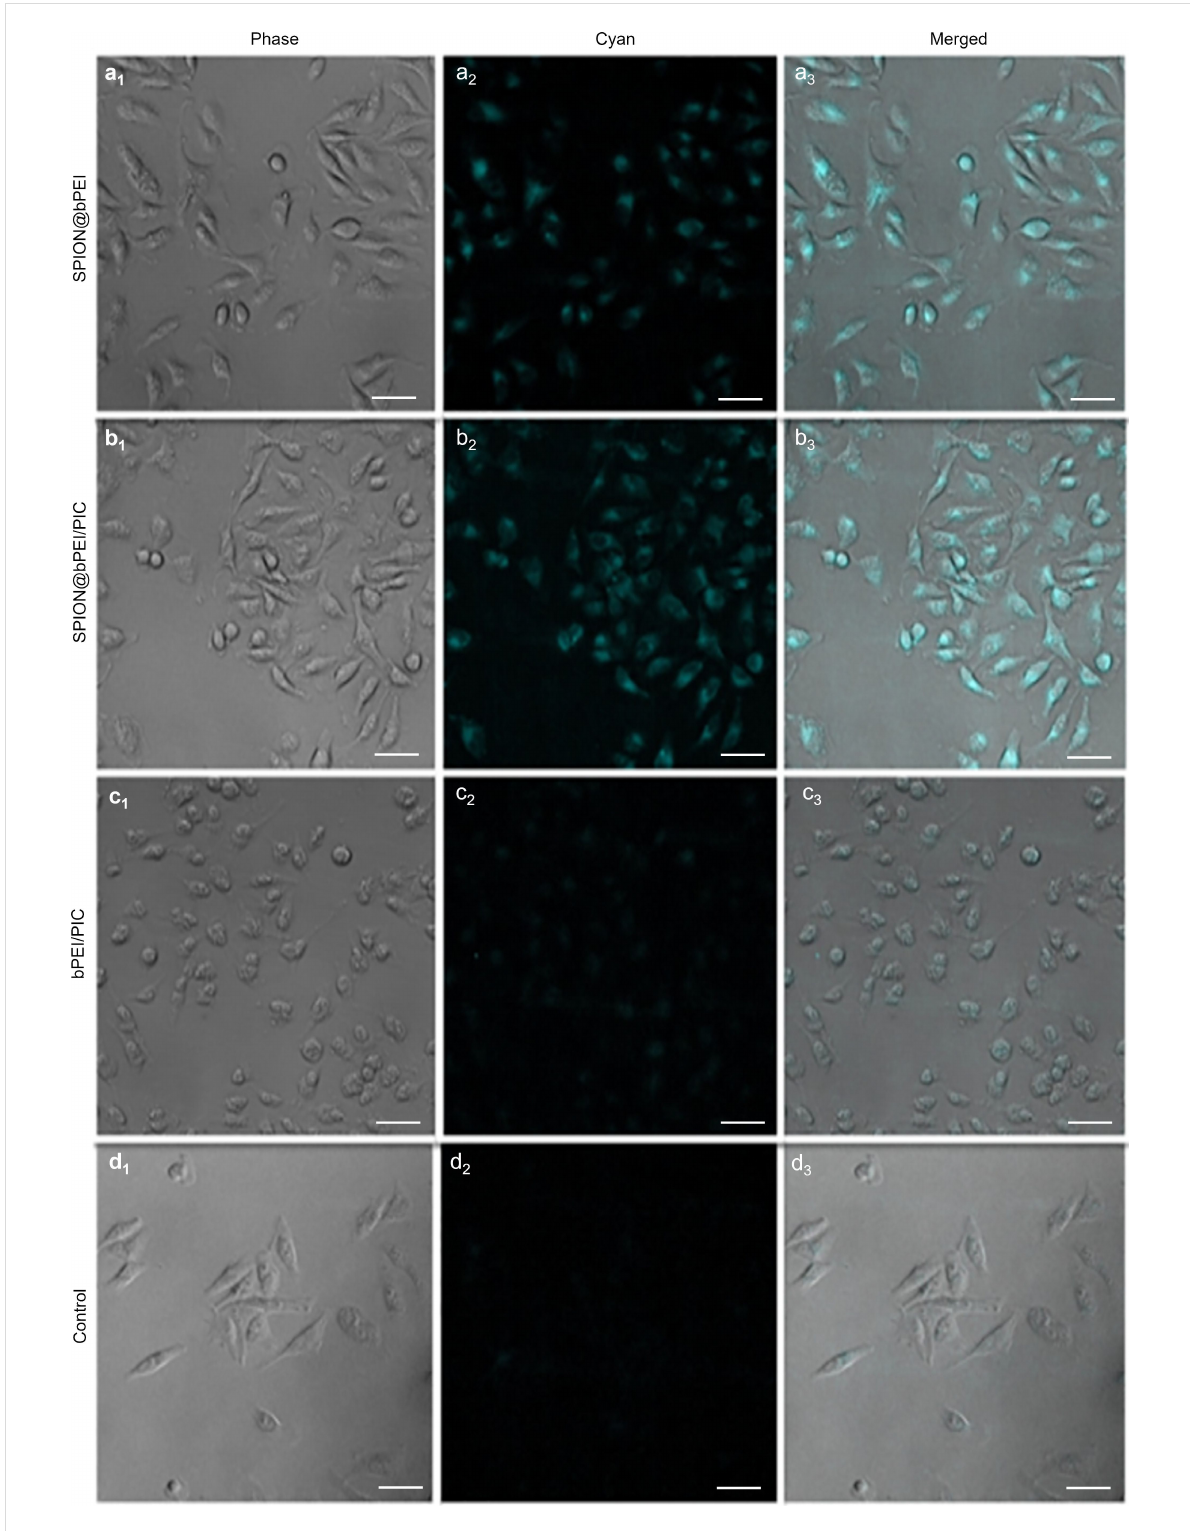
Figure 4: Fluorescence microscopy images of HeLa cells treated for 4 h with SPION@bPEI (20 μ g/mL) (a 1 –a 3 ), SPION@bPEI/PIC (N/P = 30) (b 1 –b 3 ), free bPEI (15 μ g/mL) (c 1 –c 3 ), and control untreated cells (d 1 –d 3 ) at a 20× magnification ( λ ex = 358 nm, λ em = 480 nm). Images subscribed as 1 are the phase-contrast microscopy images, images subscribed as 2 are fluorescence microscopy images (cyan), and images subscribed as 3 are merged images. The scale bar for the images is 50